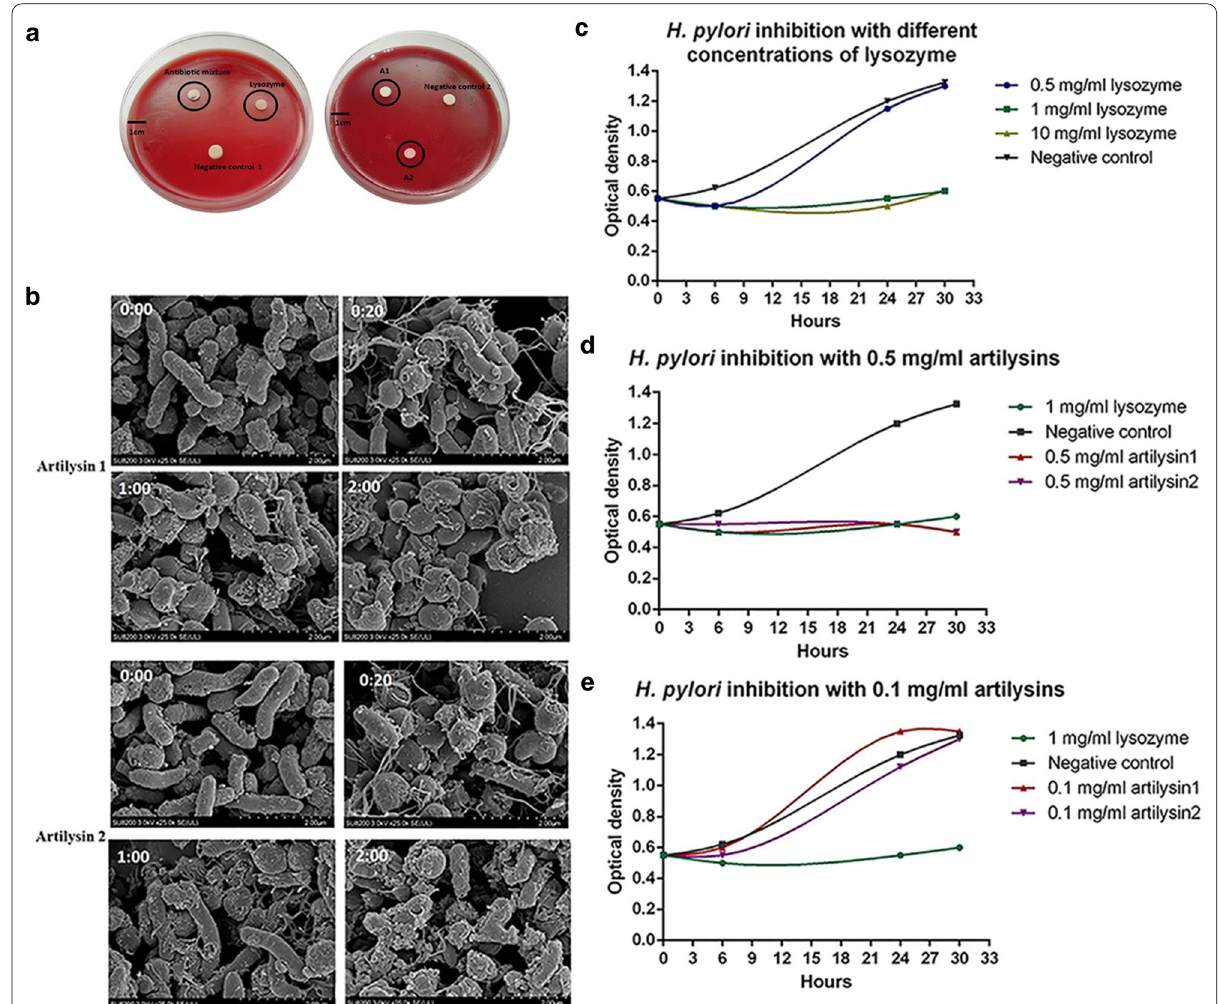
Fig. 4 In vitro antibacterial activities of artilysins. a Inhibition zone measured by the filter paper method. The petri dish diameter is 9 mm. The spots within the black circle are the corresponding inhibition zones. The antibiotic mixture and lysozyme were specifically explained in the article. A1 was Artilysin 1, A2 was Artilysin 2, Negetive control 1 was 20 mM phosphate buffer, and Negetive control 2 was the supernatant of BL21 broken bacteria with 500 u/g SUMO enzyme. b Electron microscopy images of artificial enzyme activity on H. pylori over 2 h. Time points are expressed as h:min (scale bar, 2 µm). c In vitro antibacterial effects of 500, 10 3 , and 10 4 μg/ml lysozyme on H. pylori . d In vitro antibacterial effects of 500 μg/ml artilysins on H. pylori . e In vitro antibacterial effects of 100 μg/ml artilysins on H.